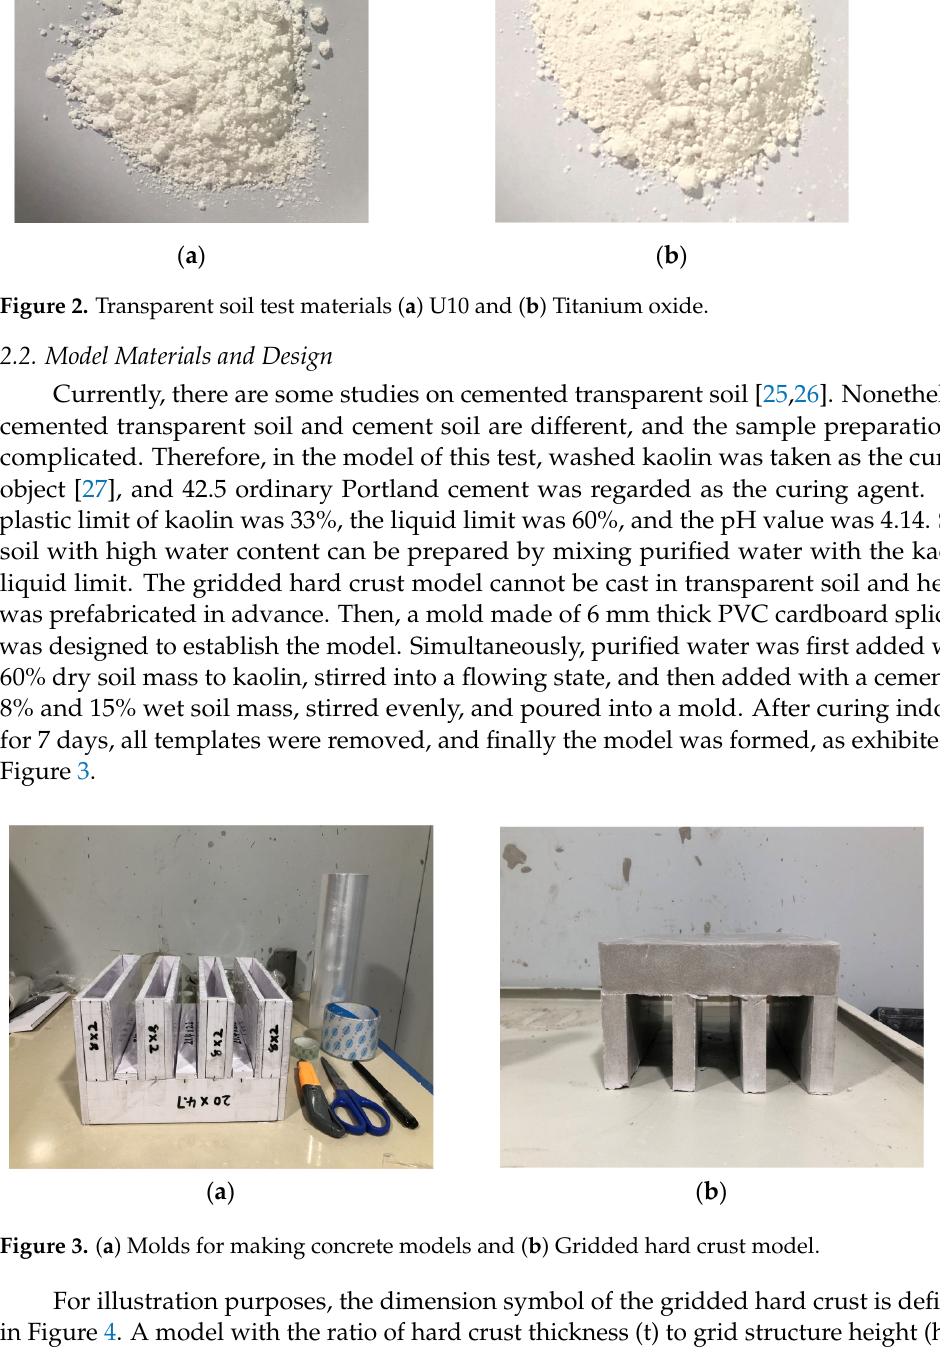
Figure 3. ( a ) Molds for making concrete models and ( b ) Gridded hard crust model.